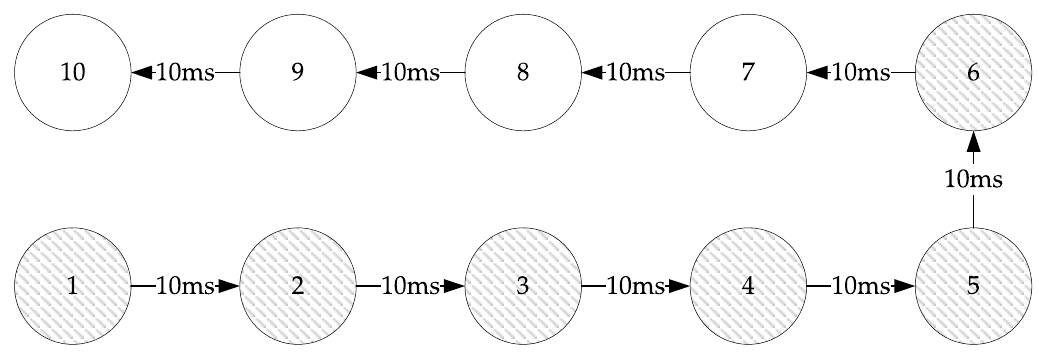
Figure 6. An example of a linear chain structure of the conventional blockchain.